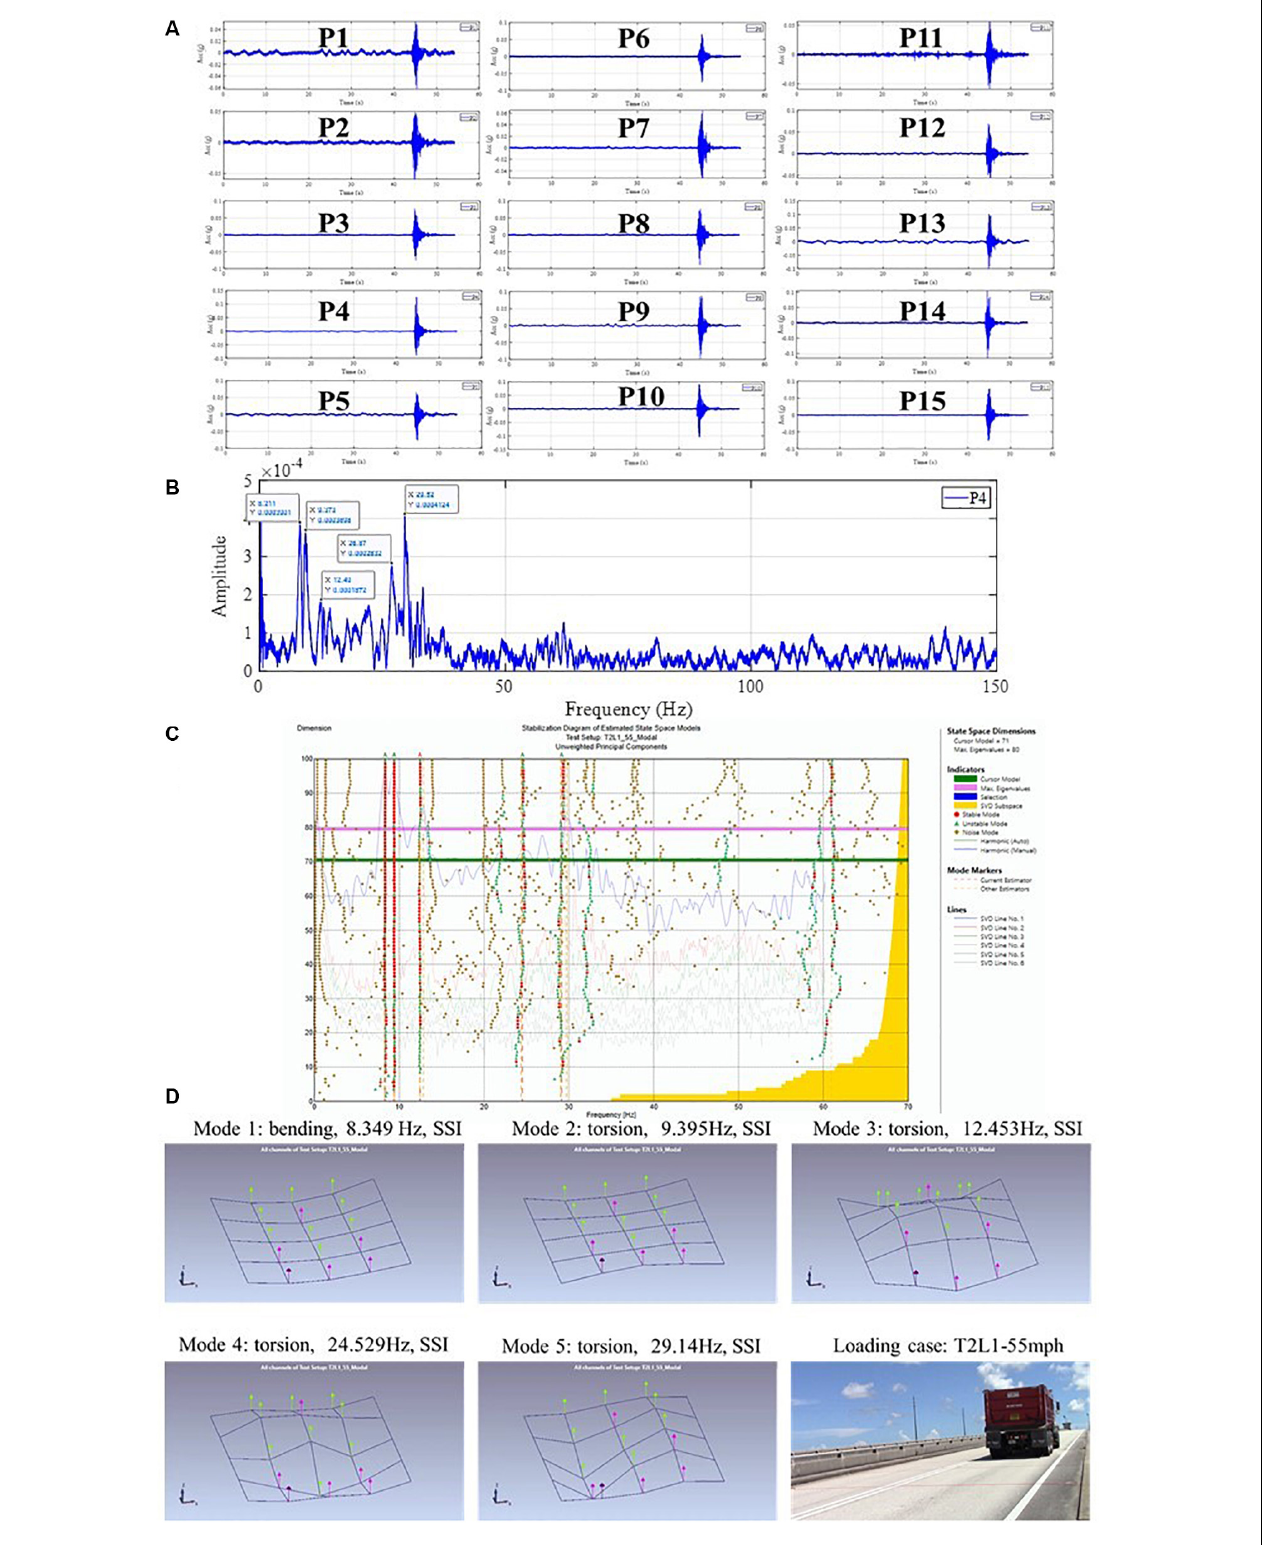
FIGURE 9 | (A) Acceleration time-histories (B) FFT analysis of P4 acceleration (C) Stabilization diagram for SDDD (D) Estimated modal characteristics.